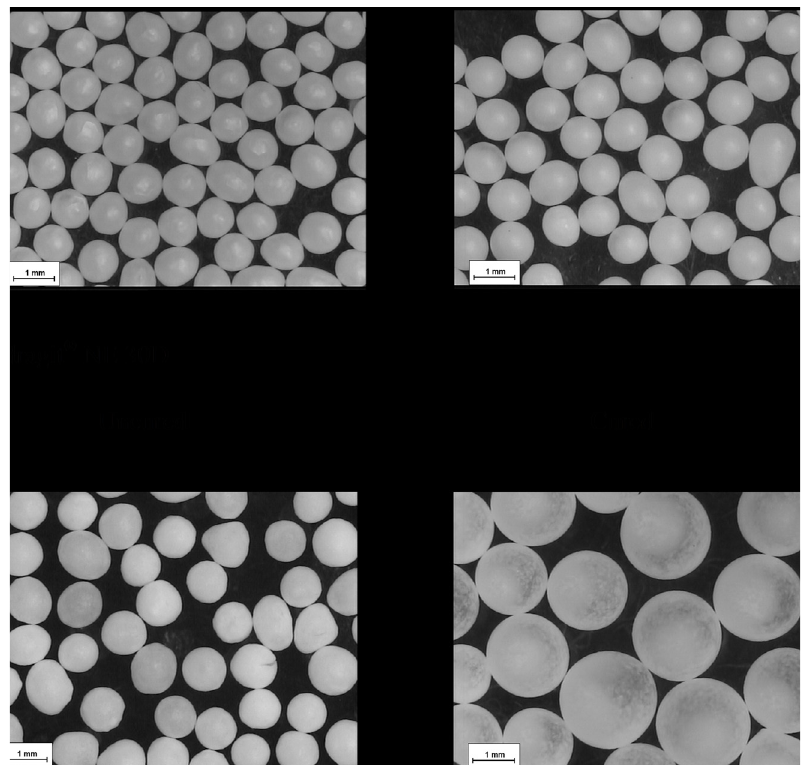
FIGURE 3 - Macroscopic pictures of uncured and cured (60 °C/75% RH/24 h) coated pellets based on sugar cores loaded with 10% propranolol HCl after drug release in 0.01 N HCl: A) Aquacoat ® ECD and B) Eudragit ® NE